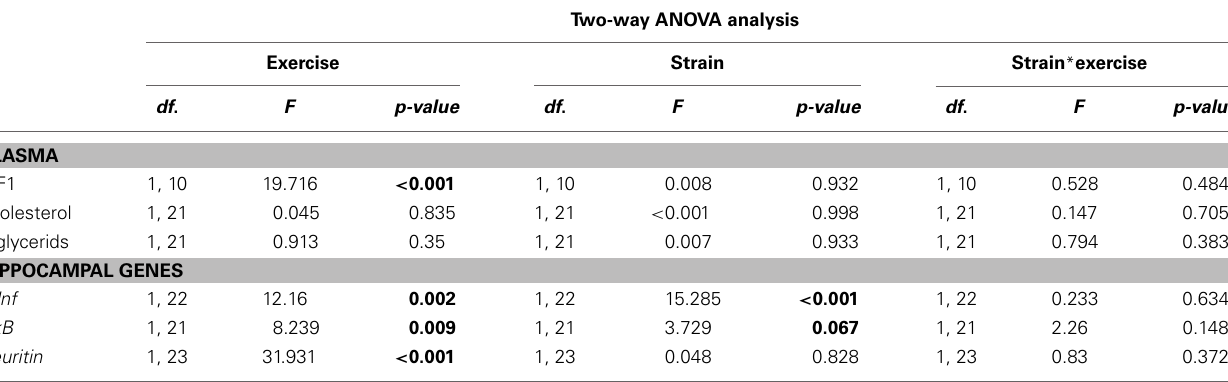
Table 1 | Two-Way ANOVA analysis was used to compare plasma cholesterol, triglycerides and IGF1 levels and hippocampal expression of neurotrophic genes in sedentary and exercised 8-month-old SAMR1 and SAMP8 mice. Two-way ANOVA analysis Exercise Strain Strain * exercise